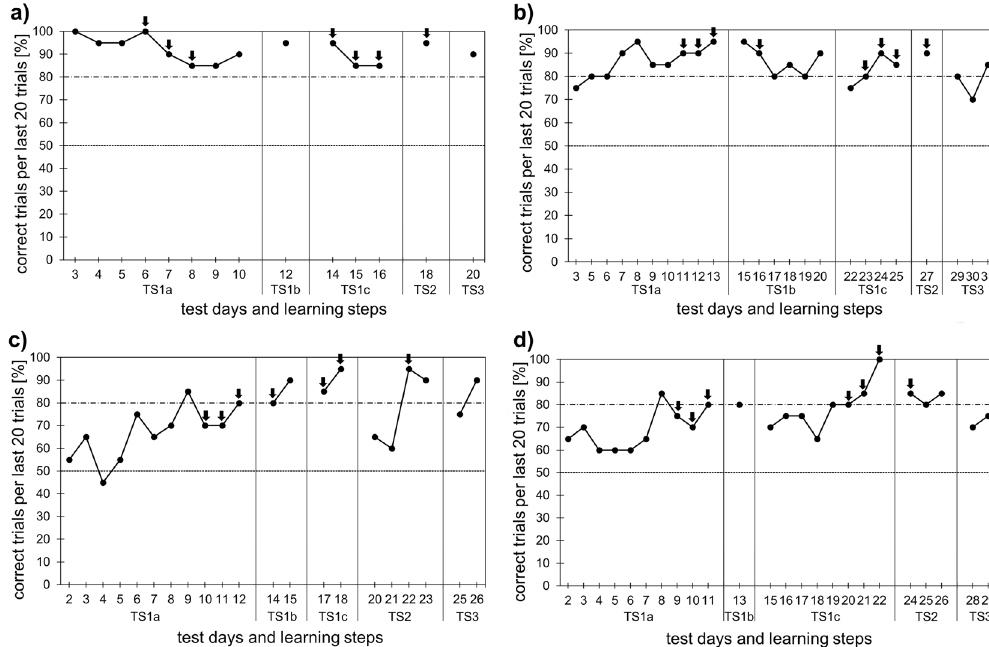
Figure 2. Learning curves of the four test animals ( a ) GND; ( b ) GIN; ( c ) PUM; ( d ) LIL across the five learning steps (Test Series 1a-3). For each day (besides the first day of each learning step), the percentage of correct trials across the last 20 trials is shown. All values above 80% (upper dotted line) indicate successful learning. The lower dotted line indicates chance level (50%). The black arrows point to those days, where the odour source was experimentally reduced. Learning steps: TS1a = without urine, inner + outer banana only on one side, step-wise reduction of outer banana to ¼ cup if animal shows significantly low error rate; TS1b = no outer banana and reduction of inner banana to ¼ slice; TS1c = introduction of rewarded urine sample and step-wise reduction of inner banana to 1/32 slice; TS2 = without any banana, step-wise reduction of pipetted urine to 5 µ l; TS3 = simultaneous presentation of rewarded and non-rewarded